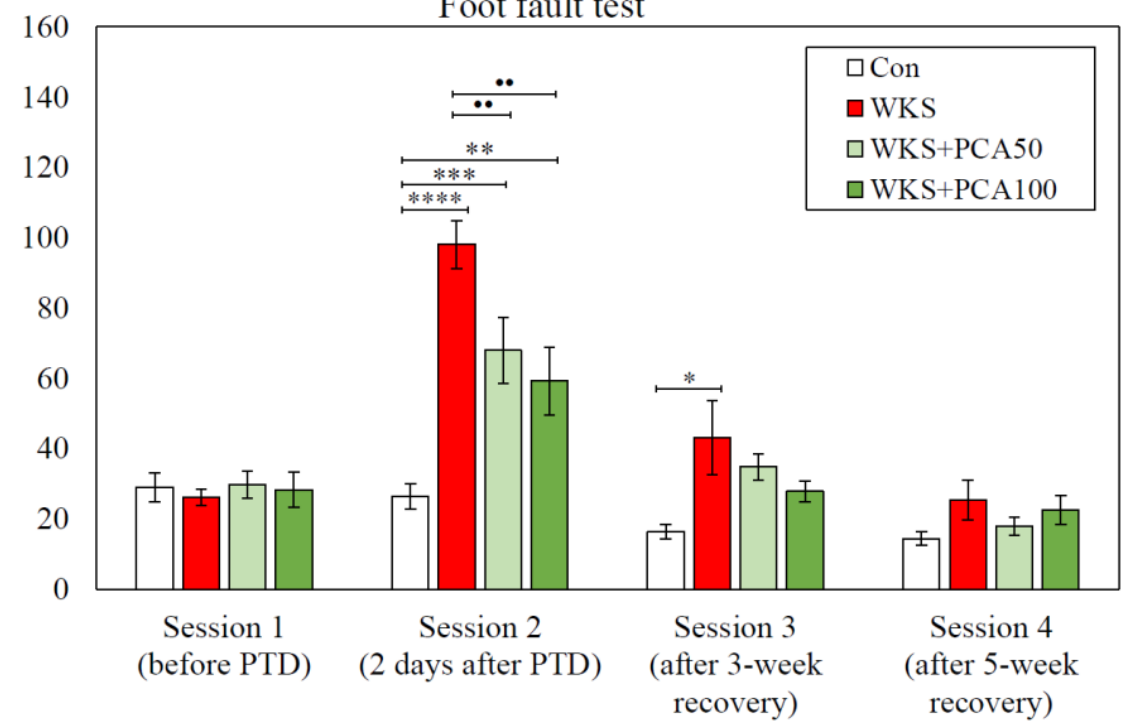
Figure 5. Time taken to cross the ladder (mean ± SEM) per session in Foot Fault test, * p < 0.05 vs.